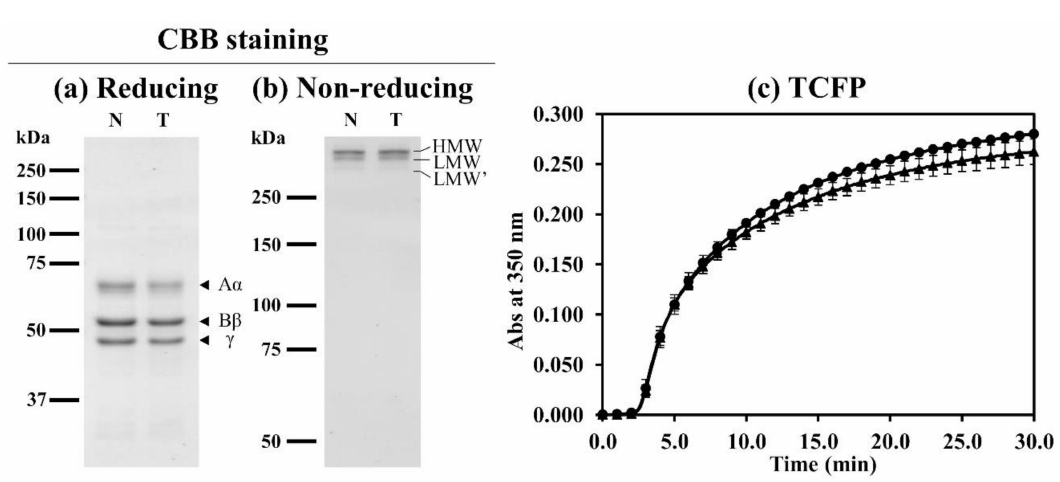
Figure 4. Characterization of purified plasma fibrinogens and thrombin-catalyzed fibrin polymerization. Purified plasma fibrinogens were resolved using SDS-PAGE in reducing conditions (Panel ( a )) or non-reducing conditions (Panels ( b )) and stained with Coomassie brilliant blue R-250 (CBB). A size marker is shown on the left side of each panel. N: Normal fibrinogen; T: Fibrinogen Tokorozawa; HMW: High molecular weight-fibrinogen; LMW: Low molecular weight-fibrinogen; LMW’: LMW’-fibrinogen. Panel ( c ): Fibrin polymerization reactions were performed in the following conditions; thrombin: 0.05 U / mL, fibrinogen: 0.18 mg / mL, CaCl 2 : 1 mM. Data are presented